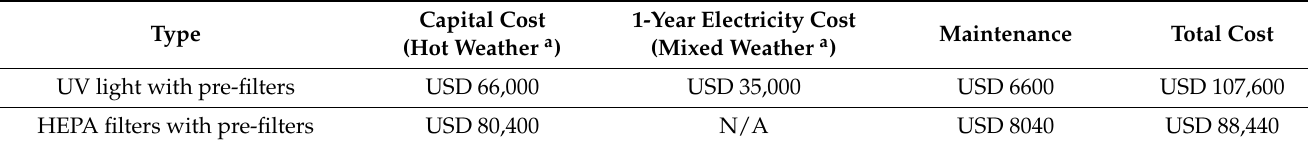
Table 5 is a summary of preliminary cost estimation of UV application vs. HEPA filtration system. Table 5. Estimations of the cost of implementing UV-C (254 nm) light or HEPA filtration treatment in a 1000-head swine barn with different swine types for 1 year. Estimations were based on extrapolations from this laboratory-scale